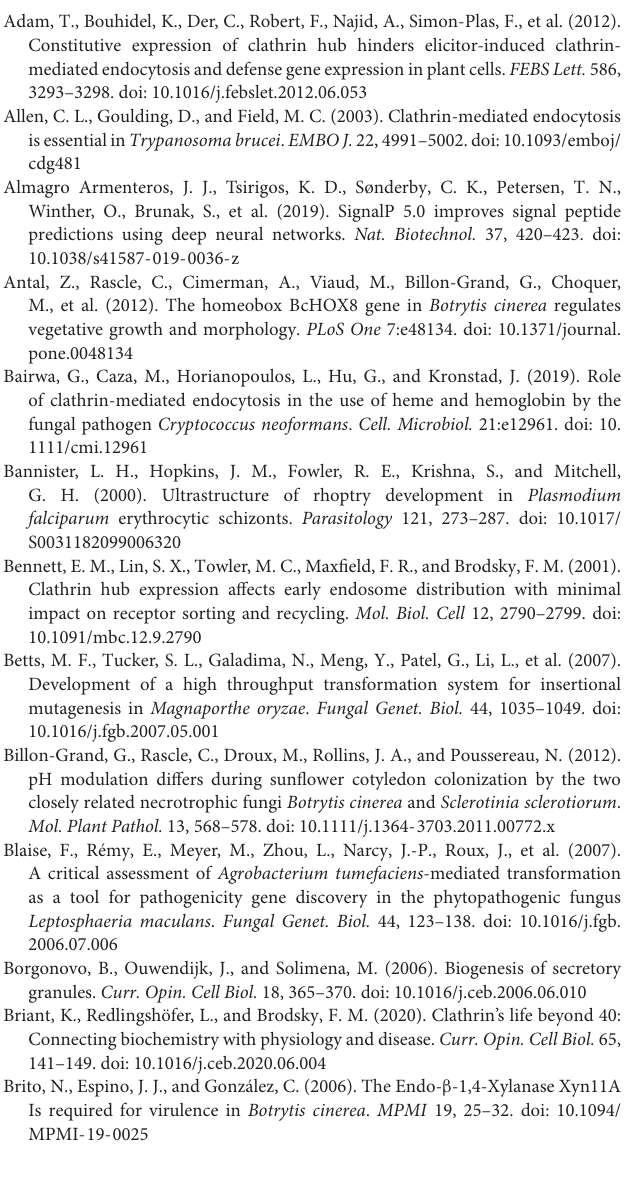
explants of young mycelia were used as inocula and pictures were taken 4 days post inoculation. Pictures are representative of three independent experiments. Supplementary Figure 3 | Identification of B. cinerea Bcchc null mutants. (A) Schematic representation of the Bcchc gene replacement by the hygromycin B resistance cassette ( hph ) flanked by 1,03 kb of 5 (cid:48) and 0,84 kb of 3 (cid:48) sequences from the Bcchc locus. Primers (black arrows; Supplementary Table 1 ) used for PCR analysis are indicated. (B) PCR amplification of the expected 5 (cid:48) (top) and 3 (cid:48) (bottom) regions of the deleted Bcchc locus in nine independent transformants (WT, parental control). The primer pairs used and the sizes of the expected bands in the transformants carrying the gene deletion are indicated (C) PCR amplification of the Bcchc gene revealing its presence in all transformants despite several rounds of single-spore isolation. The primers pairs and the expected band size in the control (WT) are